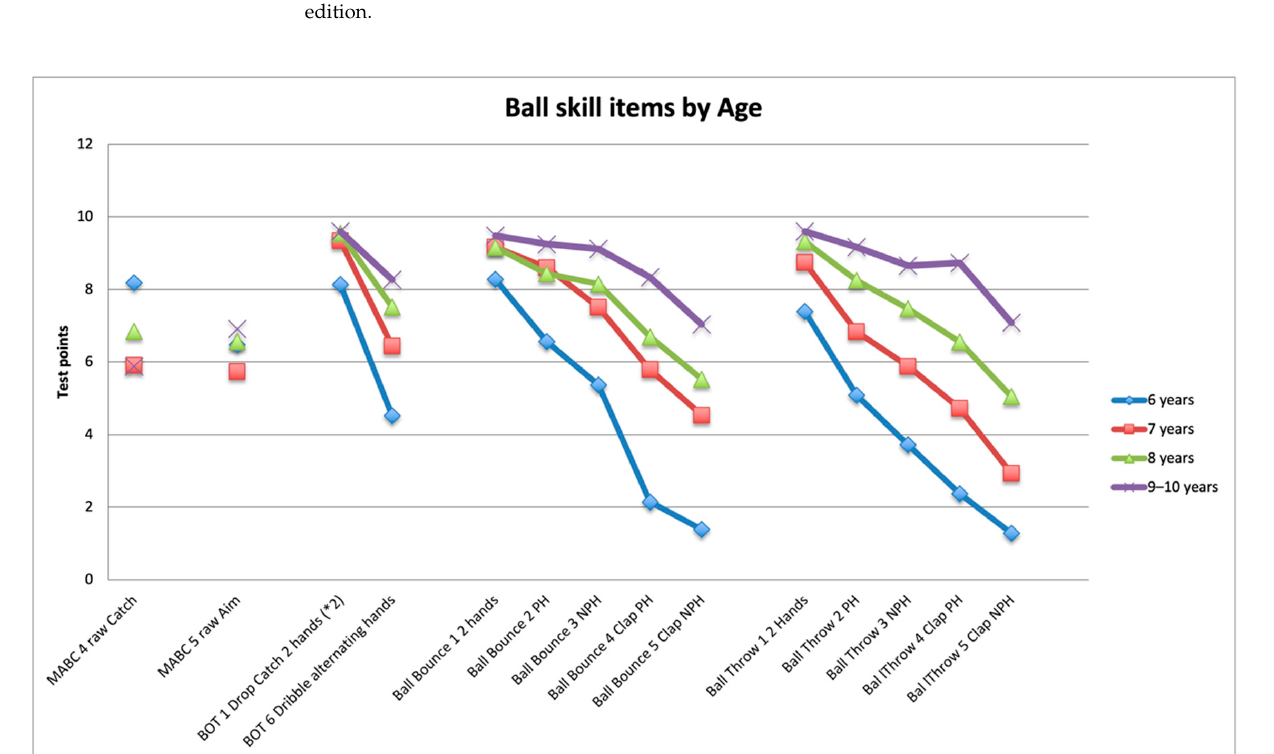
Table 6. The p -values based on Kruskal–Wallis statistics for age group comparison and based on nonparametric post hoc tests to compare differences between two adjacent groups per item.